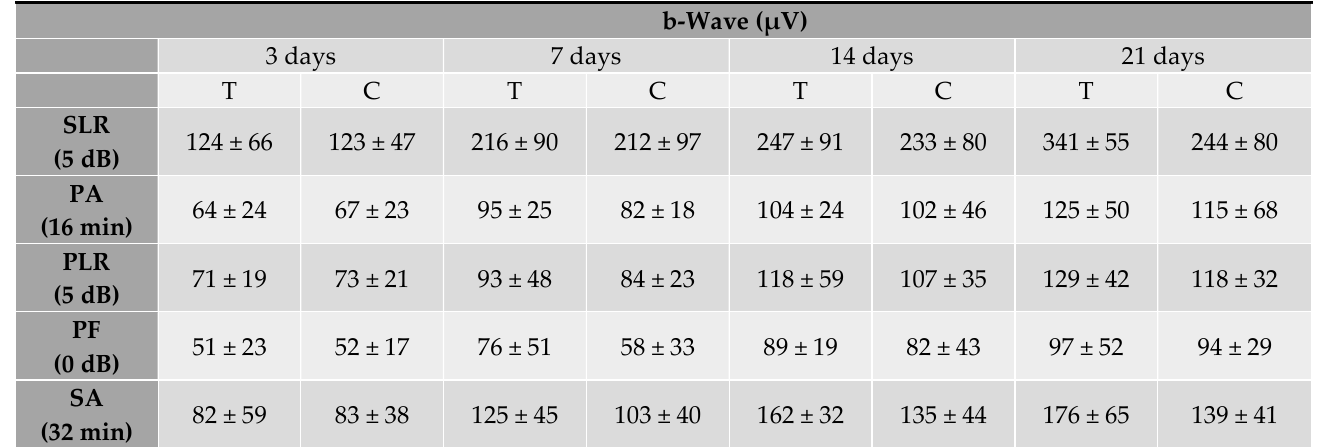
Table 3. ERG results of the OD after glaucoma induction: b-wave mean amplitudes recorded in a single step of each ERG part, presented as mean ± SD in microvolts (μV). ERGs performed in the treatment (T) and control (C) groups 3, 7, 14, and 21 days after glaucoma induction.